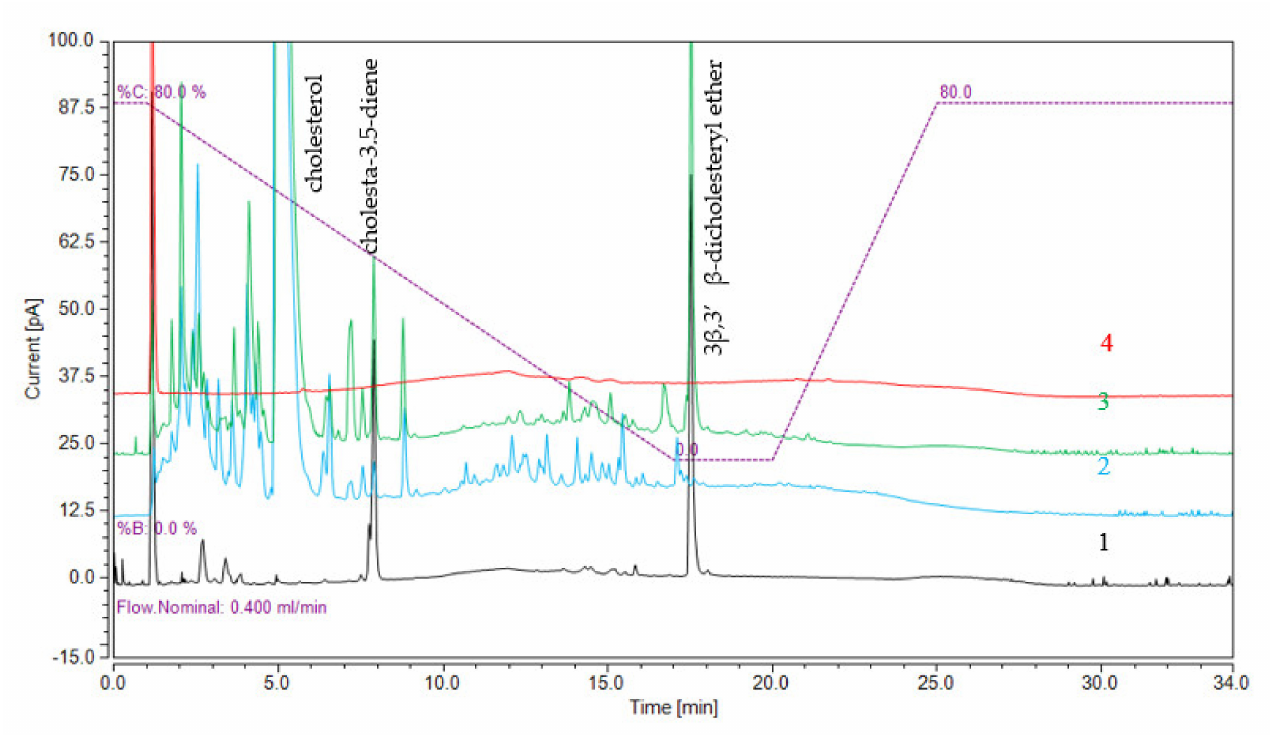
Figure 2. CAD chromatogram of analysed high-temperature samples with inorganic salts: ( 1 ) standard solution of cholesta- 3,5-diene and 3 β ,3 (cid:48) β -dicholesteryl ether, ( 2 ) cholesterol mixed with calcium salt and heated for 0.5 h at 180 ◦ C, ( 3 ) cholesterol mixed with copper salt and heated for 0.5 at 180 ◦ C, and ( 4 ) blank solution